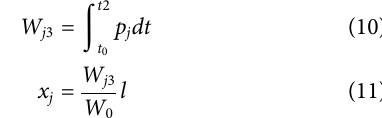
Frontiers in Energy Research |